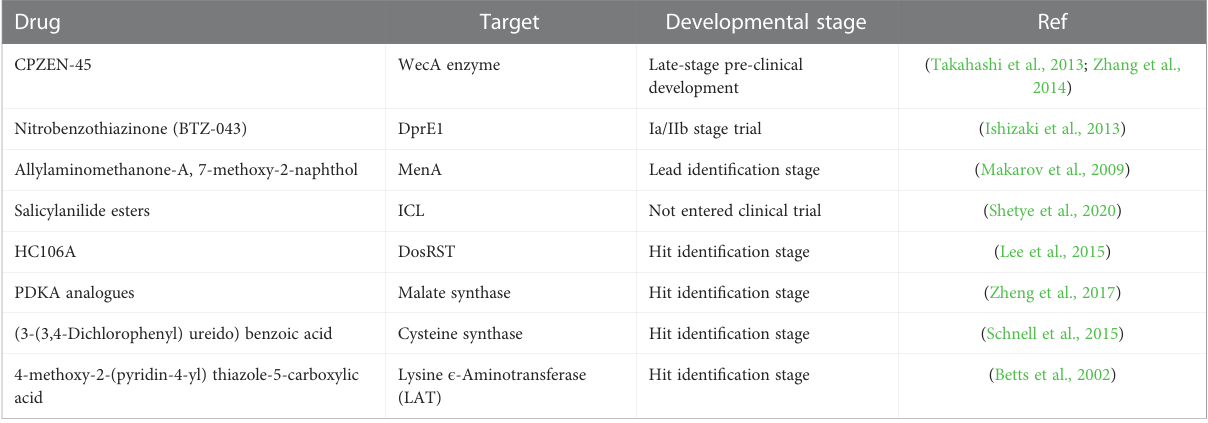
TABLE 2 List of drugs under clinical trials trial against dormant M.tb .